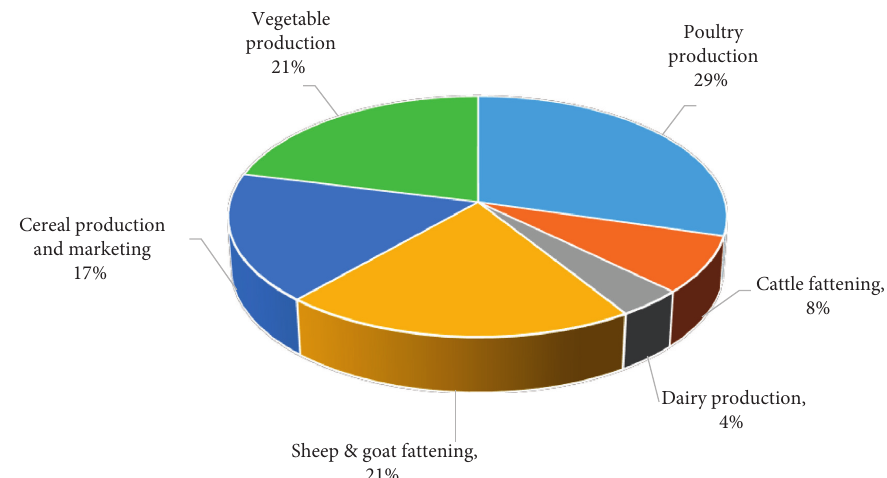
Figure 2: Types of agricultural